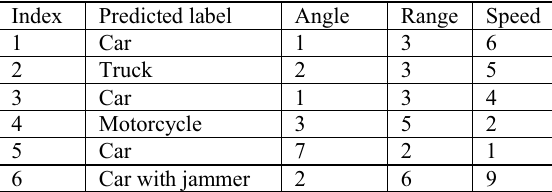
TABLE VI. INDEXATION METHOD FOR THE LABEL CAR